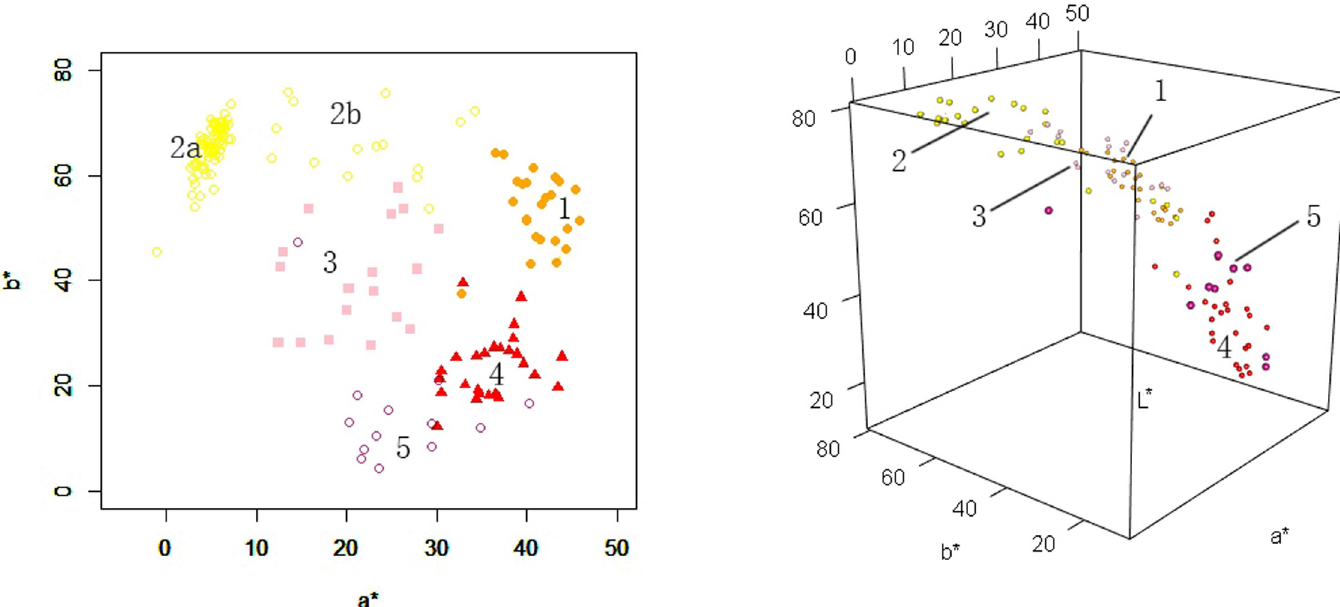
Fig 5. The flower color distribution for limb of petal of Hemerocallis. A: Two dimensional coordinate systems of a � , b � ; B: Three dimensional coordinate systems of L � , a � , b � . 1: Orange group; 2: Yellow group (2a mainly contain edible daylily, 2b mainly contain horticultural cultivars); 3: Pink group; 4: Red group; 5: Purple group.